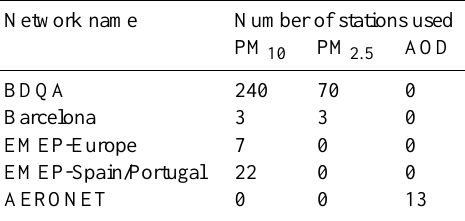
Figure 3. Hourly averaged range-corrected lidar signals (PR 2 ) from 06:00UTC 9 July to 06:00UTC 12 July at the Barcelona, Bucharest, Corsica and Madrid lidar stations. Figure 3. Hourly-averaged range corrected lidar signals (PR 2 ) from 06:00 UTC 9 July to 06:00 UTC 12 July at Barcelona, Bucharest, Corsica and Madrid lidar stations. Table 3. Number of stations used for PM 2 . 5 , PM 10 or AOD in the different